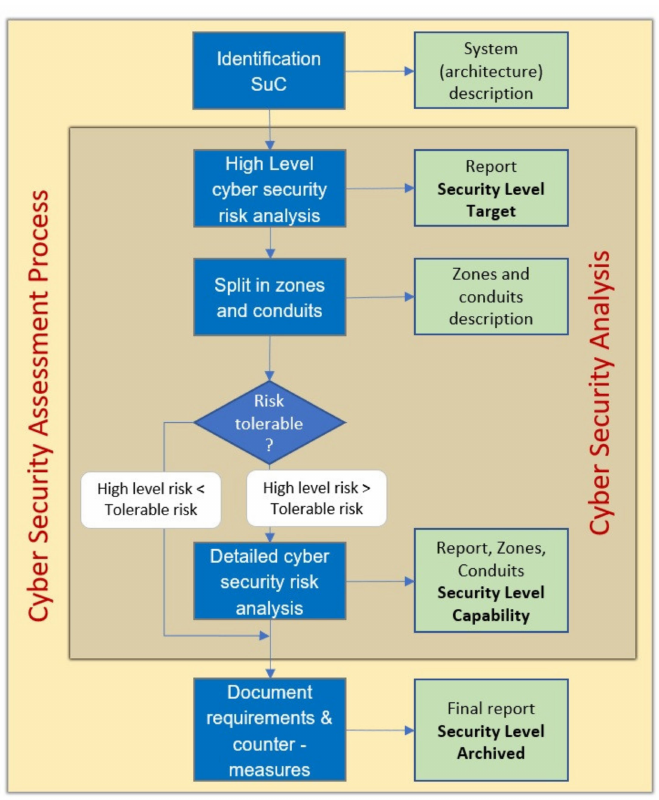
Figure 2. IEC 62443 cybersecurity process